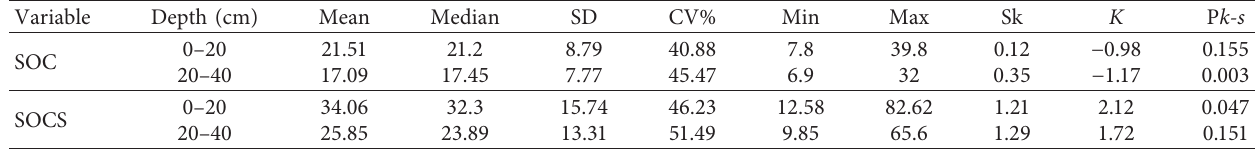
Table 1: Descriptive statistics of SOC and SOCS at the two